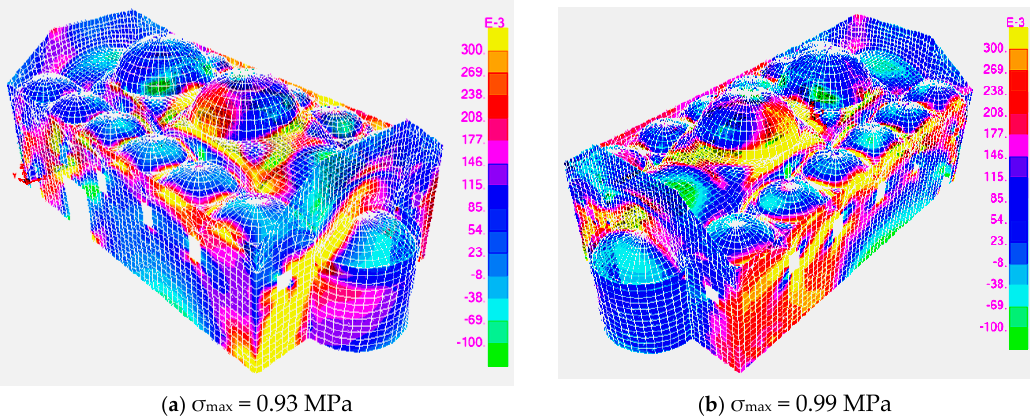
Figure 12. Deformable foundation ( a ) distribution of maximum tensile stresses South-East view ( b ) distribution of maximum tensile stresses North-East view. The scale at the far right of each plott indicates that the colours used to represent stress values in this numerical representation of the structure are ranging from 0.1 MPa to -0.1 MPa. Yellow colour indicates stress values excedding 0.3 MPa.